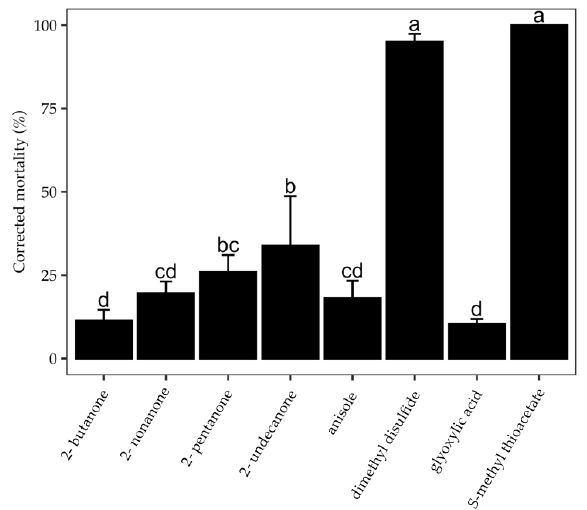
Figure 2. Fumigant activity of VOCs at a dosage of 40 µ g/cm 3 air against C. elegans for 24 h . The values show the corrected mortality rate of the tested VOCs compared with the control group. Bars indicate the standard error (SE) of the means. Data were analyzed by one-way ANOVA. Different letters indicate significant differences of means ± SE. The worms used in the treatments were mainly L1s with only a few adults.